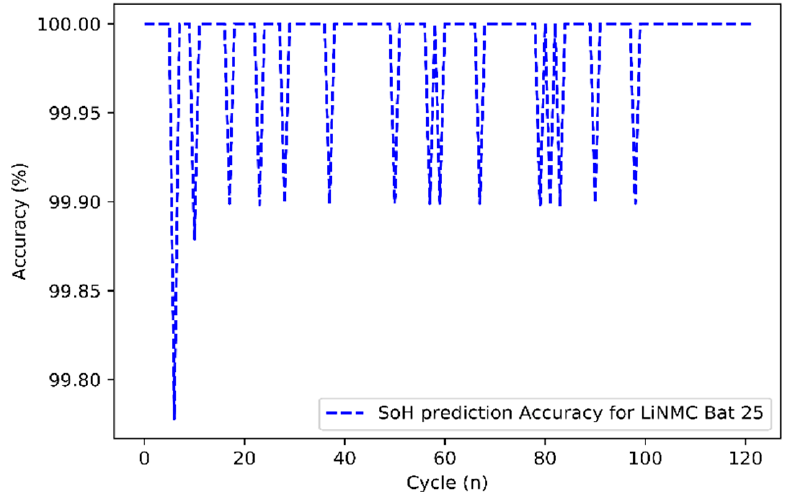
Figure 12. The accuracy in prediction of SOH for battery 25.